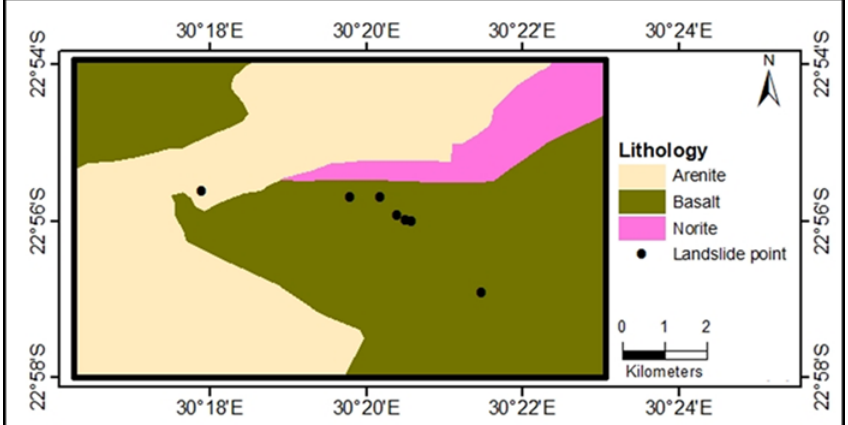
Figure 4. Constructed geological through geological mapping.